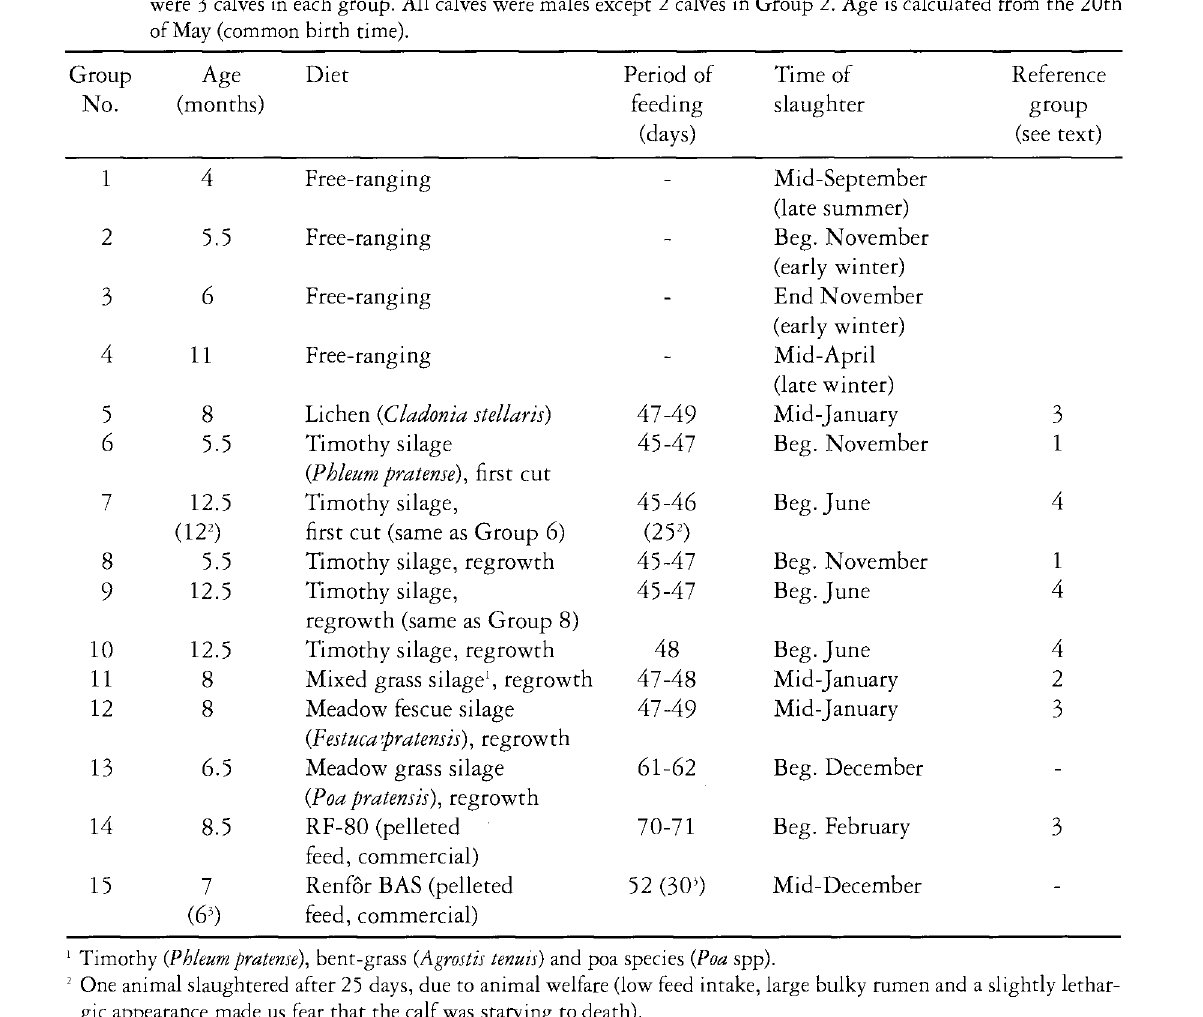
Table 1. Groups of reindeer calves used to study the influence of diet on the morphology of ruminal papillae. There were 3 calves in each group. All calves were males except 2 calves in Group 2. Age is calculated from the 20th of May (common birth time). Period of Time